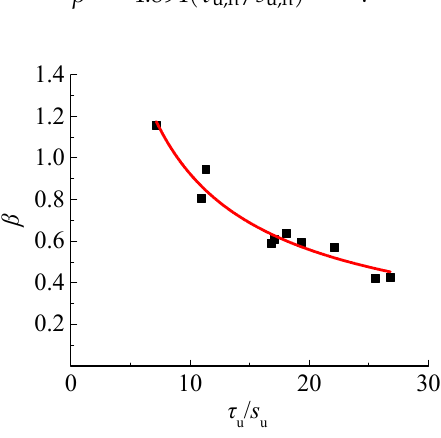
Figure 13. Impact of τ u / s u on coefficient β .